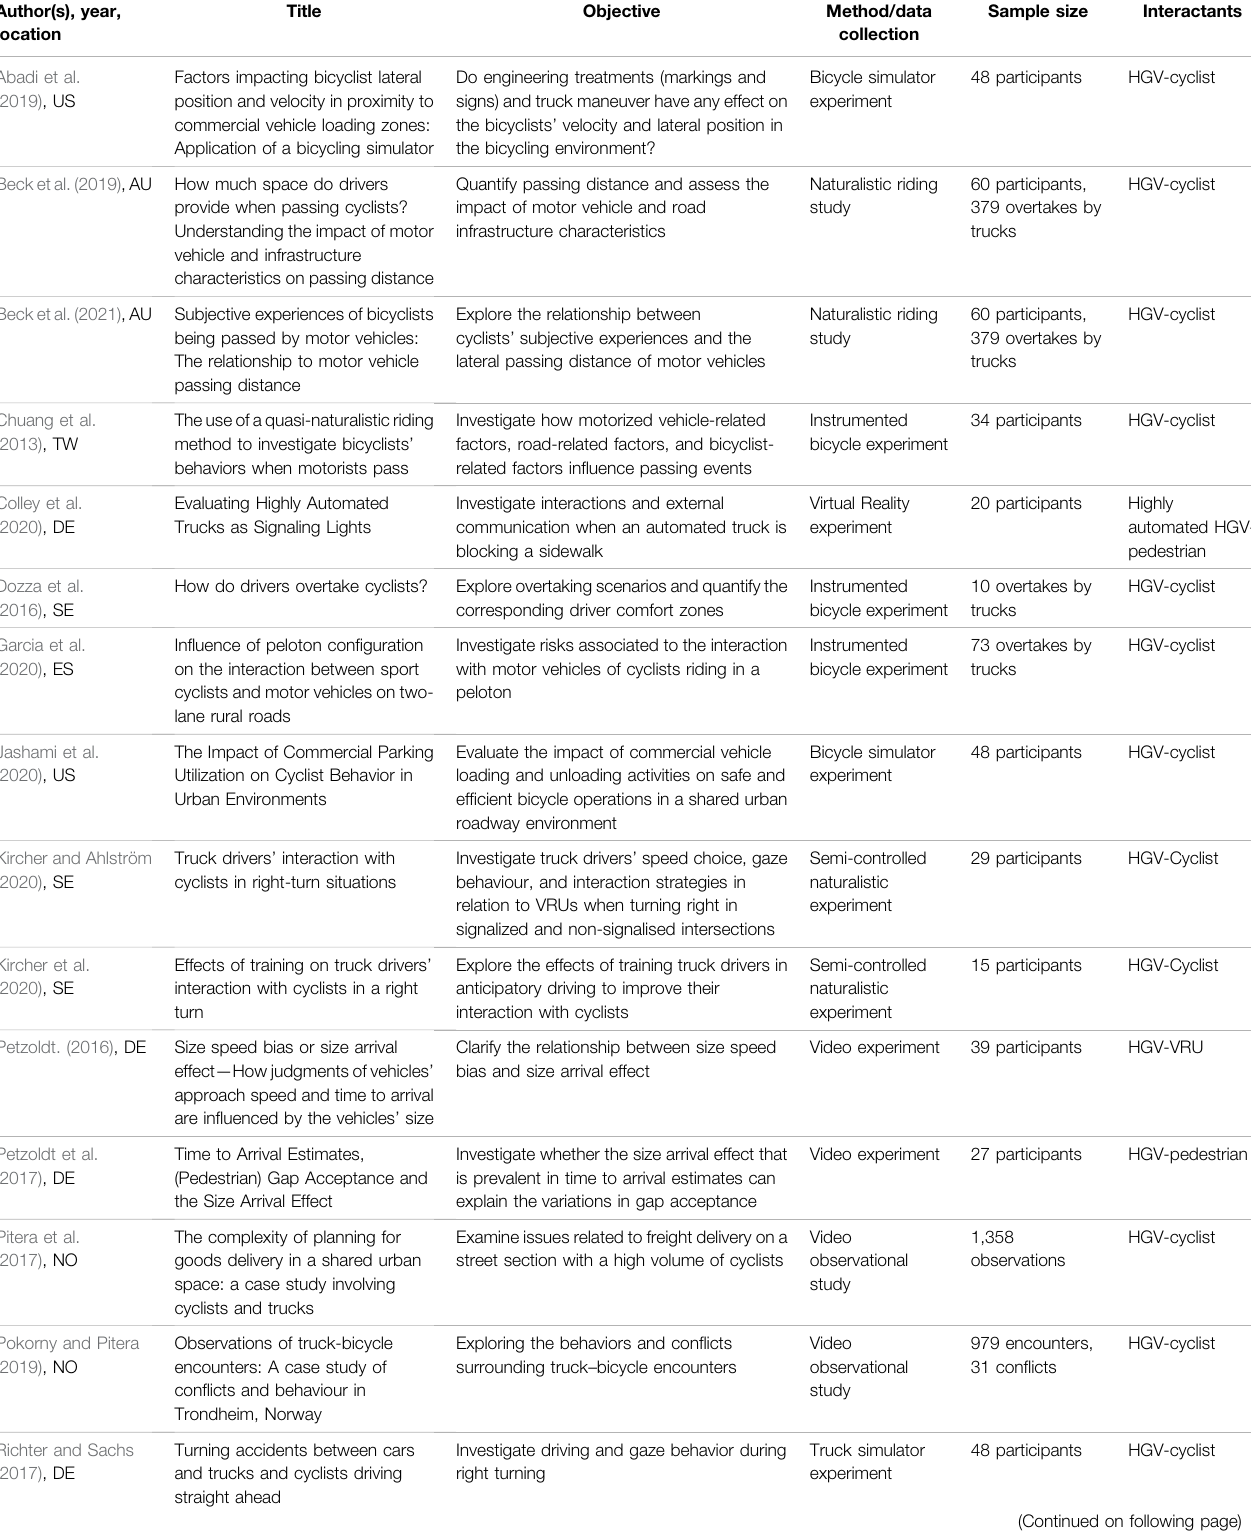
TABLE 2 | Basic characteristics of the included